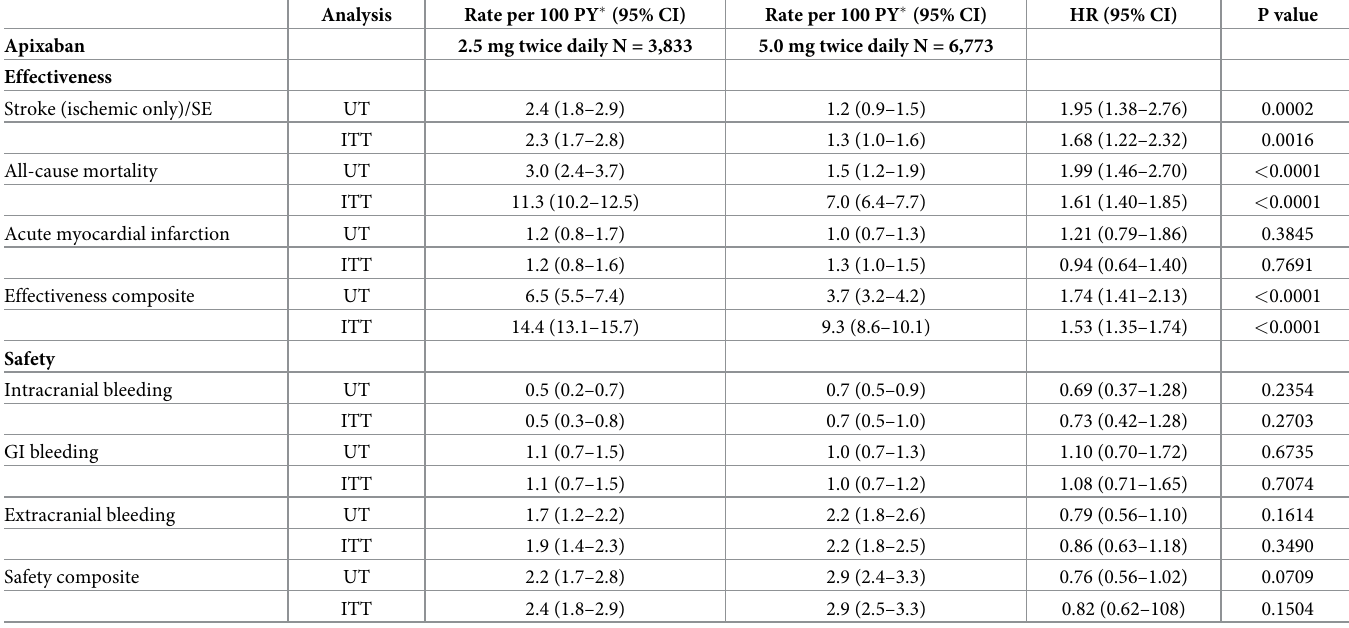
Table 3. Comparative effectiveness and safety of low-dose and standard-dose apixaban after inverse probability of treatment